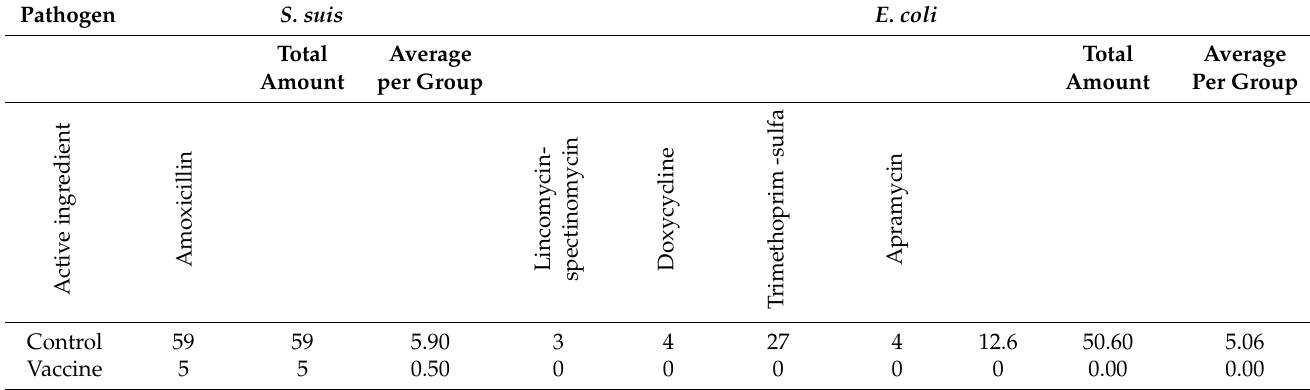
Table 3. Summary of active ingredients of antimicrobials (expressed in kg of commercial product; including calculated total amount and average amount of product per group) administered for treatment of S. suis and E. coli in the 10 batches of the control group and 10 batches of the vaccine- treated